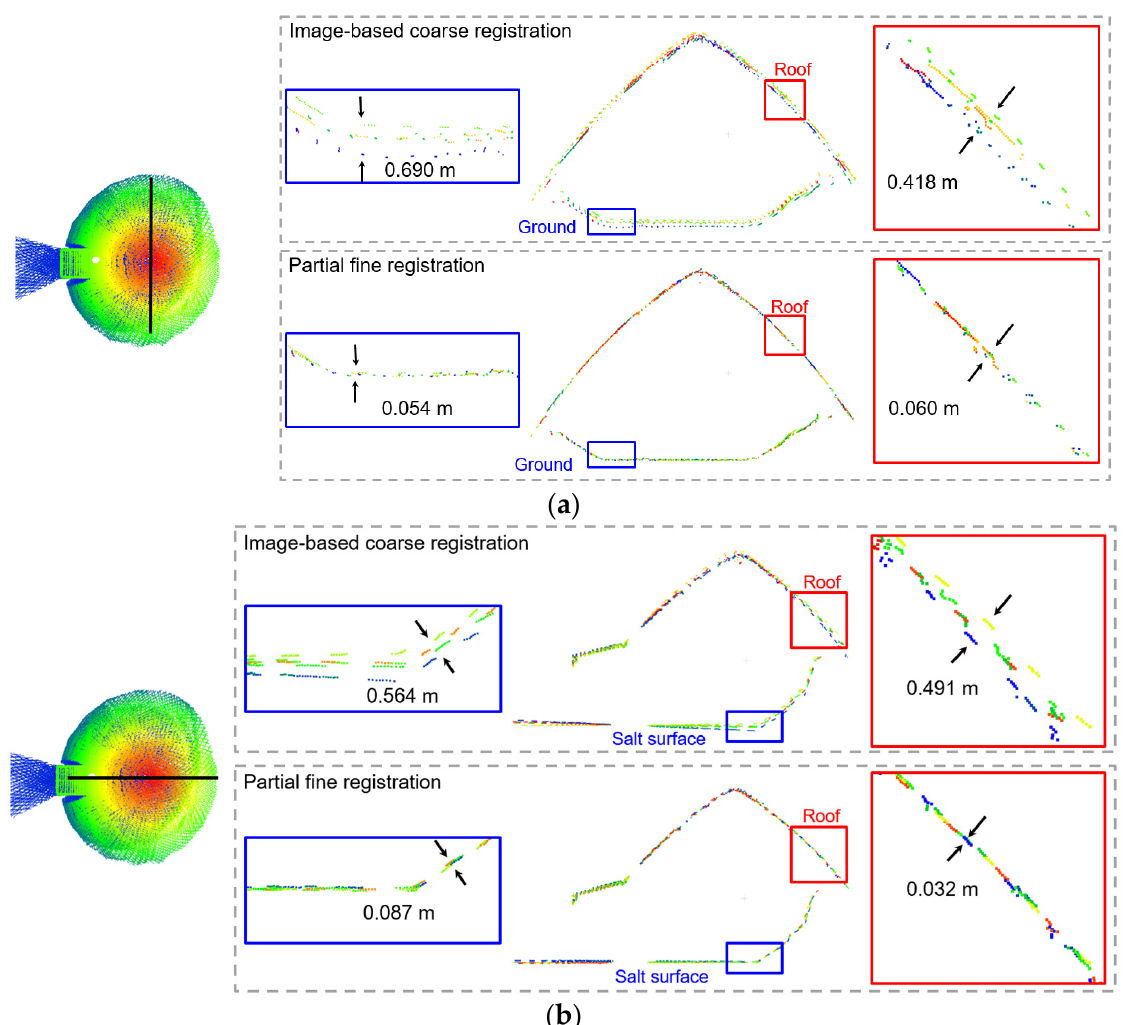
Figure 29. Extracted vertical profiles (width: 0.2 m) from the Frankfort dataset before/after partial fine registration (the arrows indicate the direction of the measured distance): ( a ) profile orthogonal to the entrance walls and ( b ) profile parallel to the entrance walls.